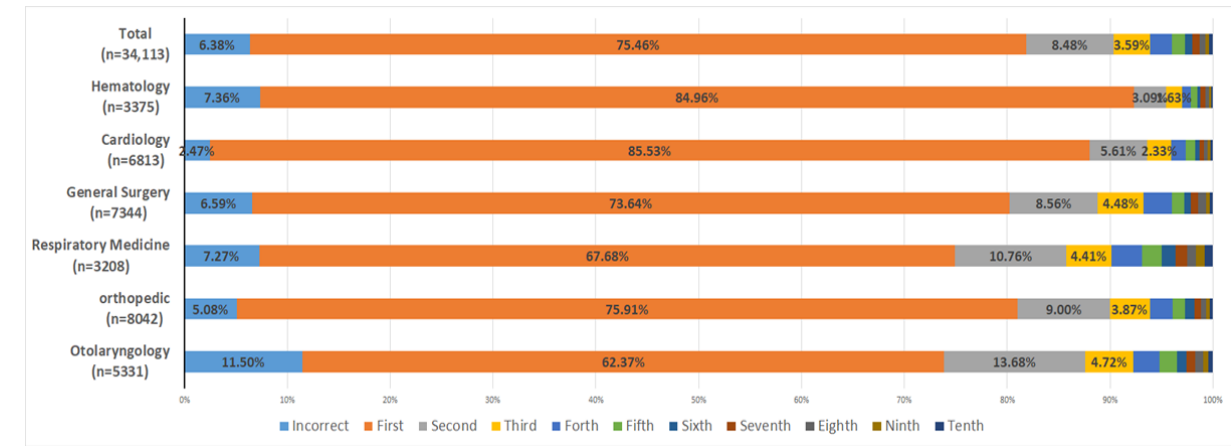
Figure 2. Accuracy of the 10 recommended diagnoses from the CDSS (clinical decision support systems) before implementation in the electronic medical records. “Incorrect” means none of the 10 recommended diagnoses were consistent with the patient’s discharge diagnosis; “first” means the first recommended diagnosis was consistent with the patient’s discharge diagnosis; “second” means the second recommended diagnosis was consistent with the patient’s discharge diagnosis, and so